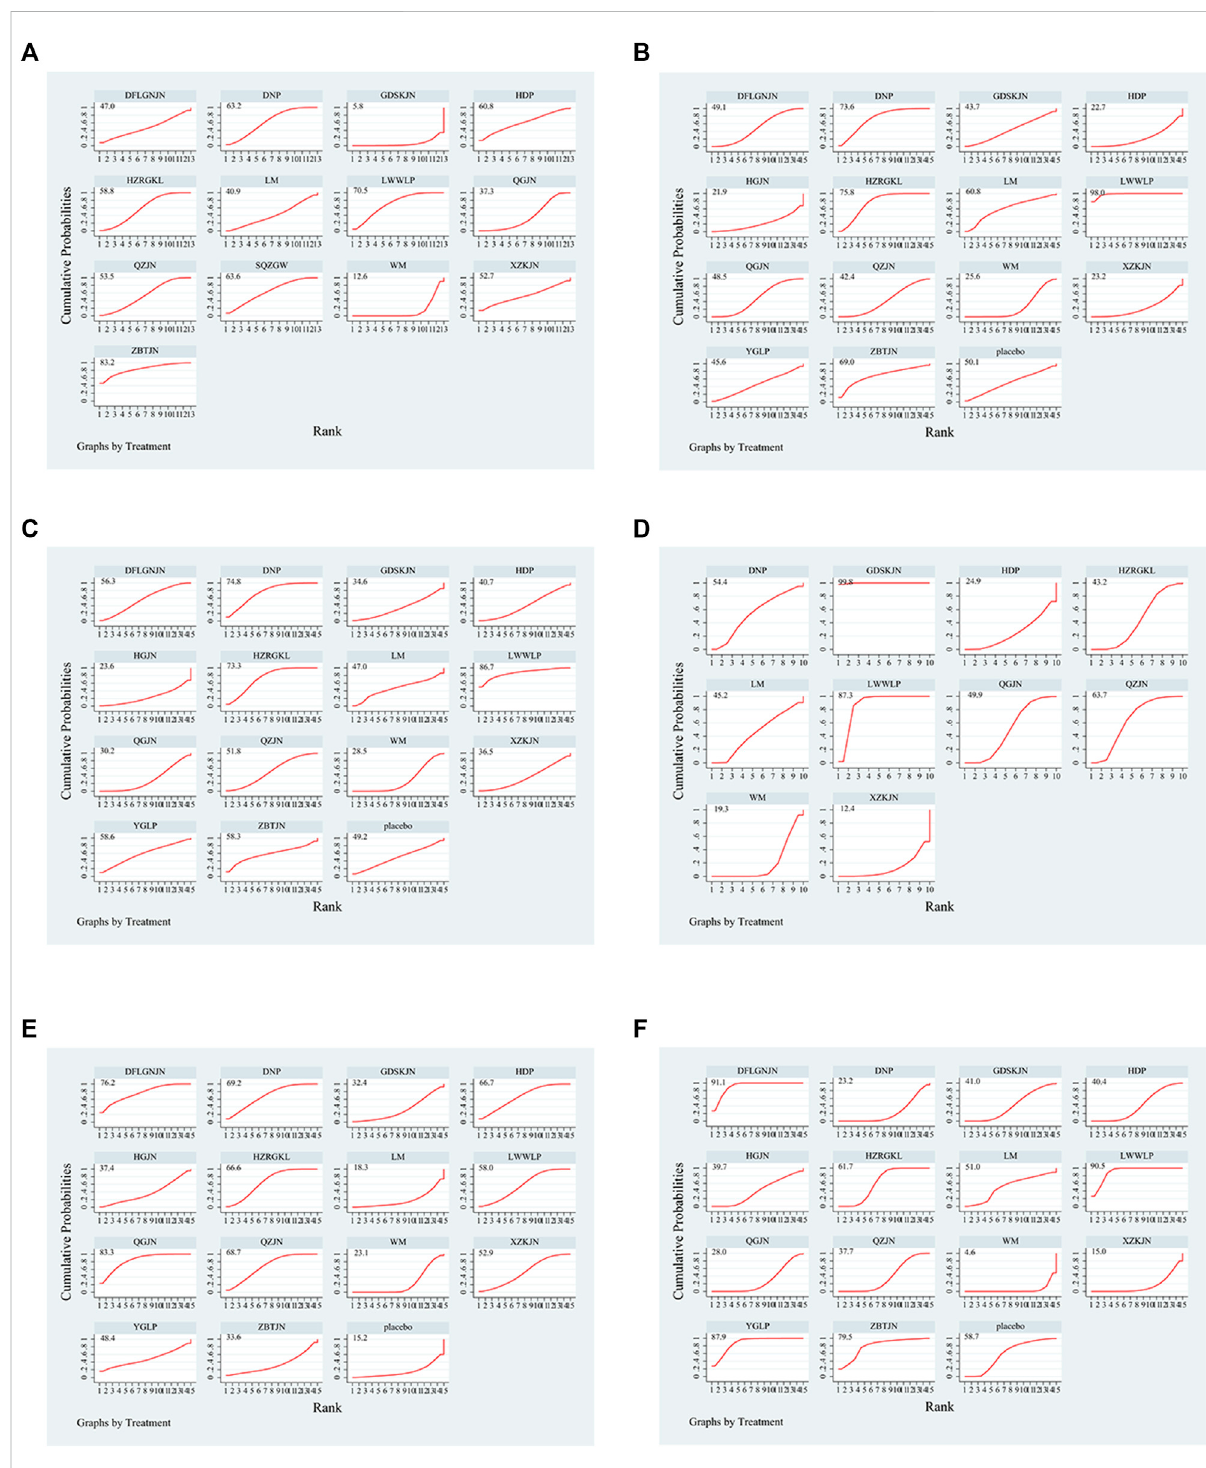
FIGURE 4 Summary of results from SUCRA (A) Clinical ef fi ciency rate (B) ALT (C) AST (D) GGT (E) TG (F) TC; WM, Western medicine; QGJN, Qianggan capsule; DFLGNJN, Dangfei Liganning capsule; DNP, Danning tablet; HZRGKL, Huazhi Rougan granule; QZJN, Qiaozhi capsule; SQZGW,